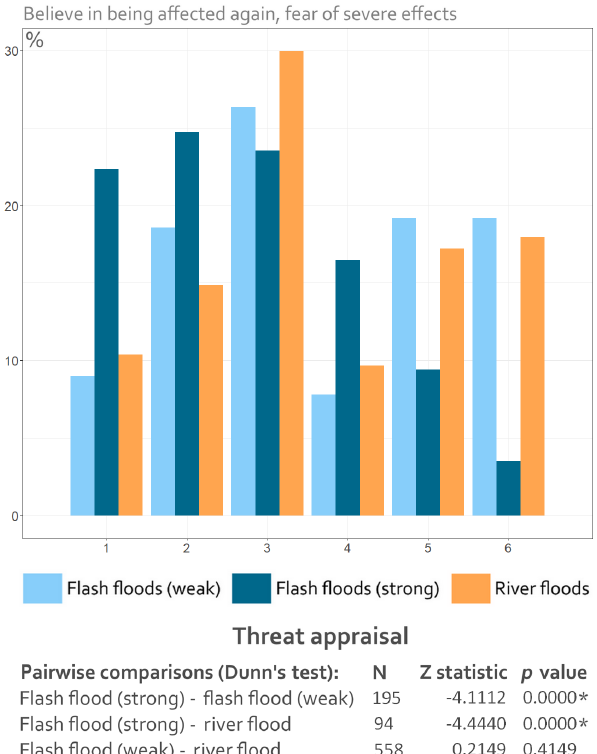
Figure A4. Relative distribution of threat appraisal among each flood type and Dunn’s test results. The data were corrected for flood expe- rience, i.e. all households which only experienced a flood once. The results of the Dunn test reveal the direction shift of each distribution compared to the other distributions (negative means a shift towards lower values, positive a shift towards higher values) by also indicating the strength and significance of the shift ( Z statistic and p